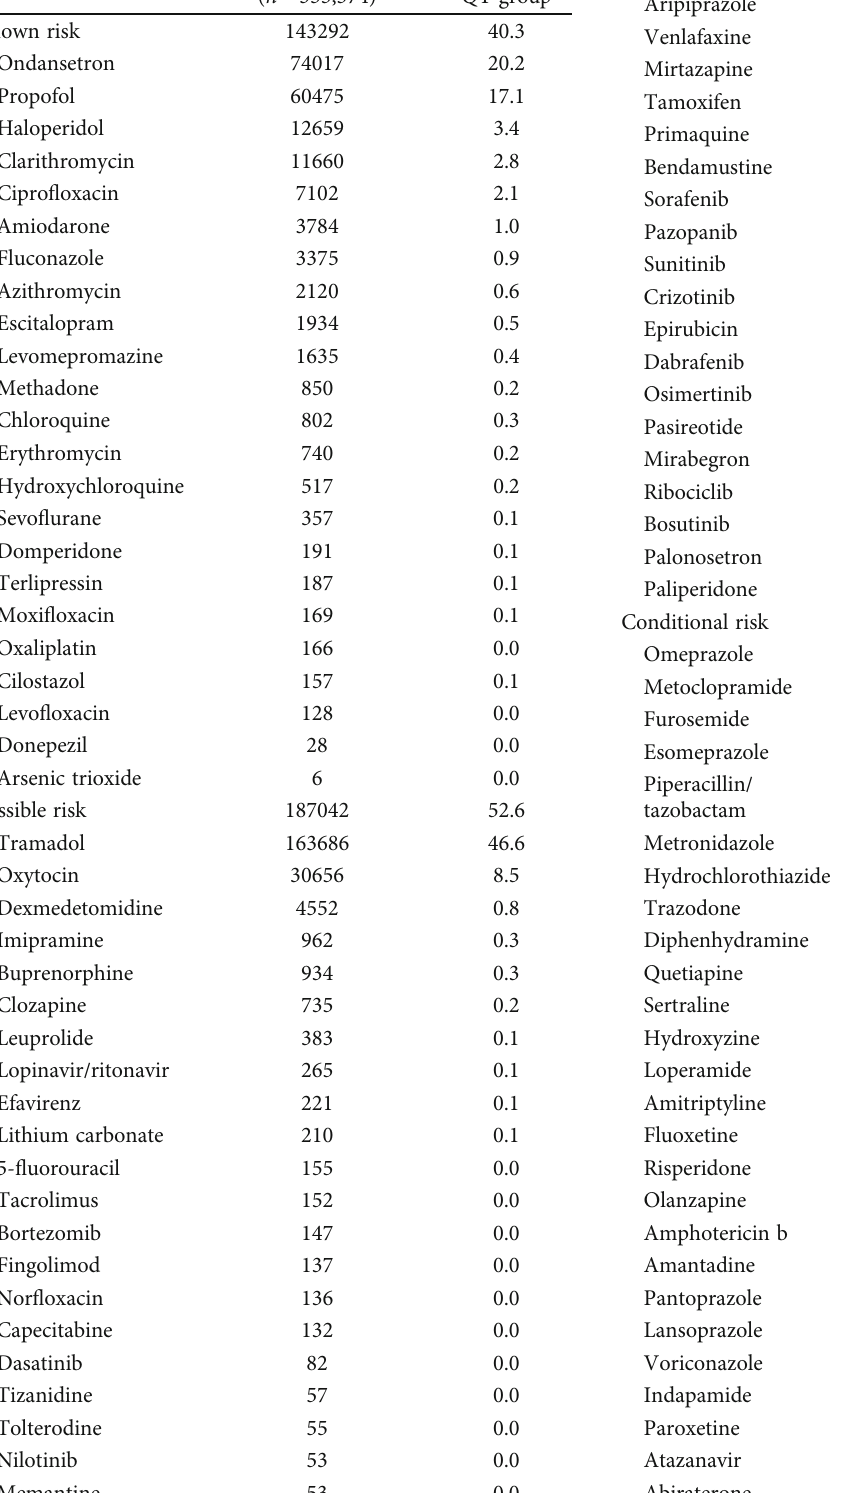
Table 3: QT-prolonging drugs used in 355,574 patients in 21 hospital institutions, Colombia, January – December 2020.